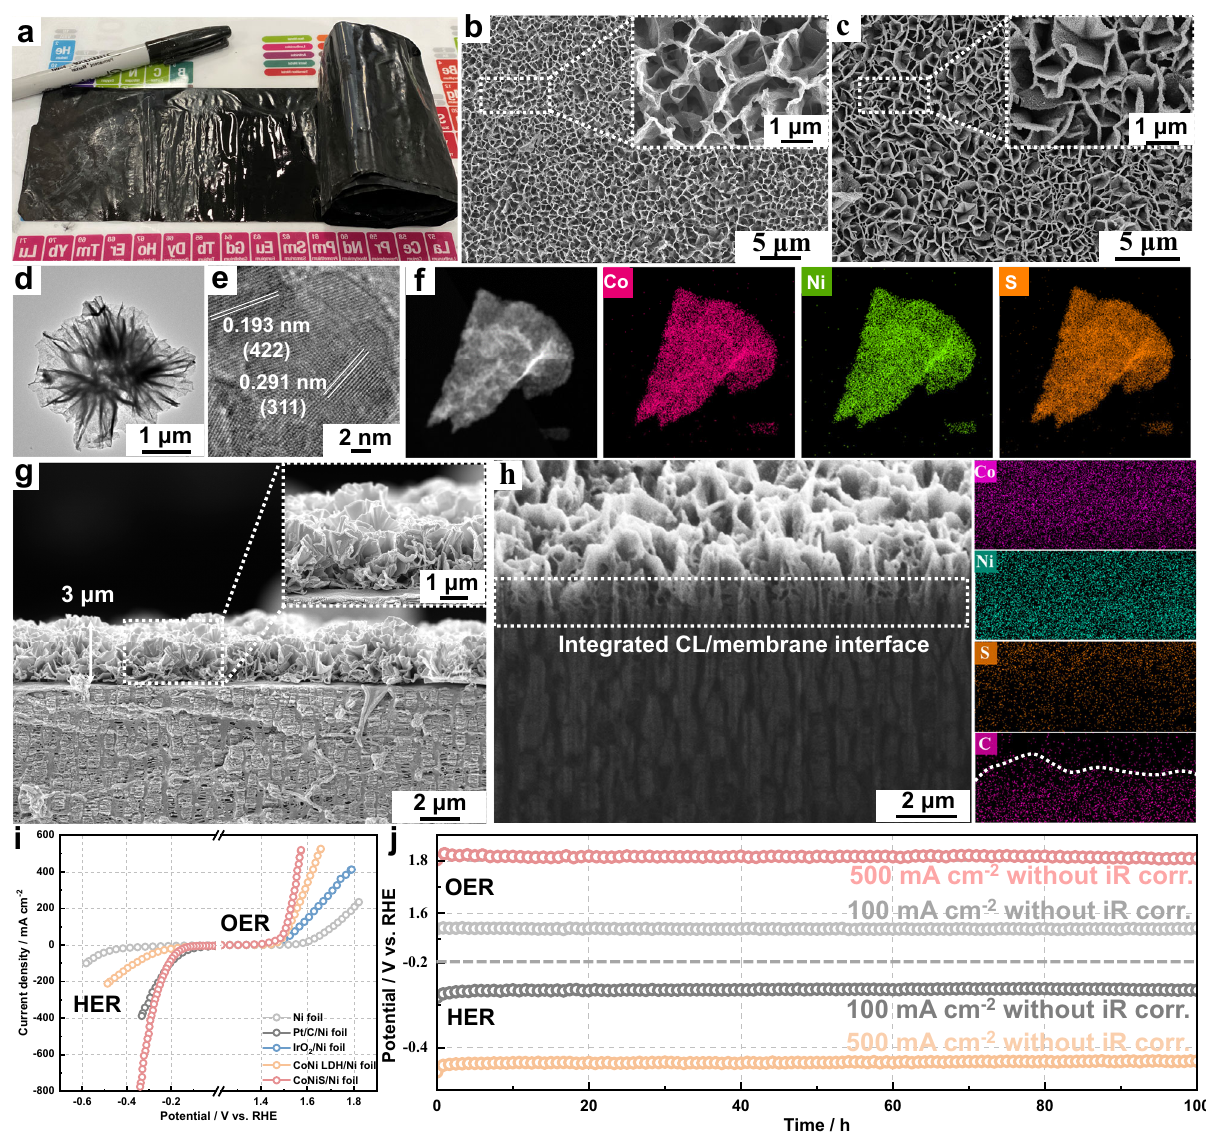
Fig. 2 | Morphological and catalytic activity characterisation of the all-in-one MEAs.a Opticalimageoftheall-in-oneMEA-S.SEMimagesofthe b all-in-oneMEA-L surface and c all-in-one MEA-S surface. d TEM and e HRTEM images of the CoNiS nanosheets. f Elemental mapping images of the CoNiS nanosheets. g Cross- sectionalSEMimageoftheall-in-oneMEA-S. h Cross-sectionalSEMimageoftheCL